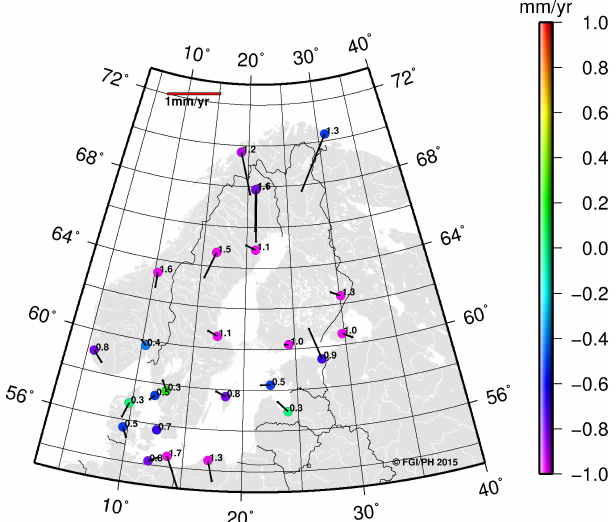
Figure 3: Observed ETRF2000 station velocities of the EPNC1785 minus original NKG RF 03 vel intraplate velocities. Vectors show horizontal, coloured circles vertical and values next to the station 3D differences in mm/yr.